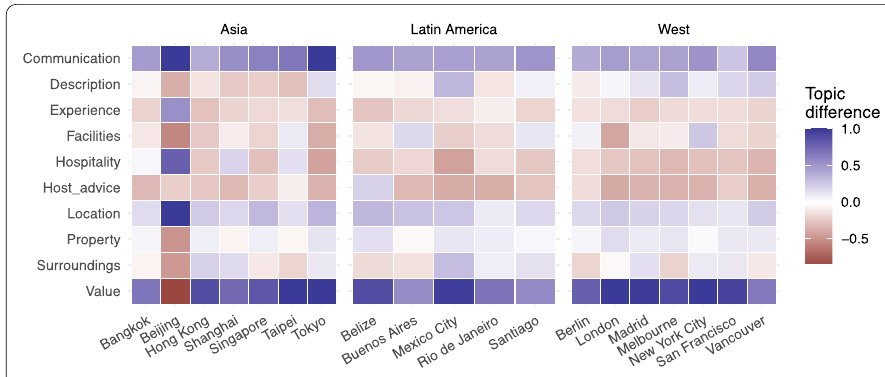
Figure 12 Percentage change of topic importance from 2015 to 2019